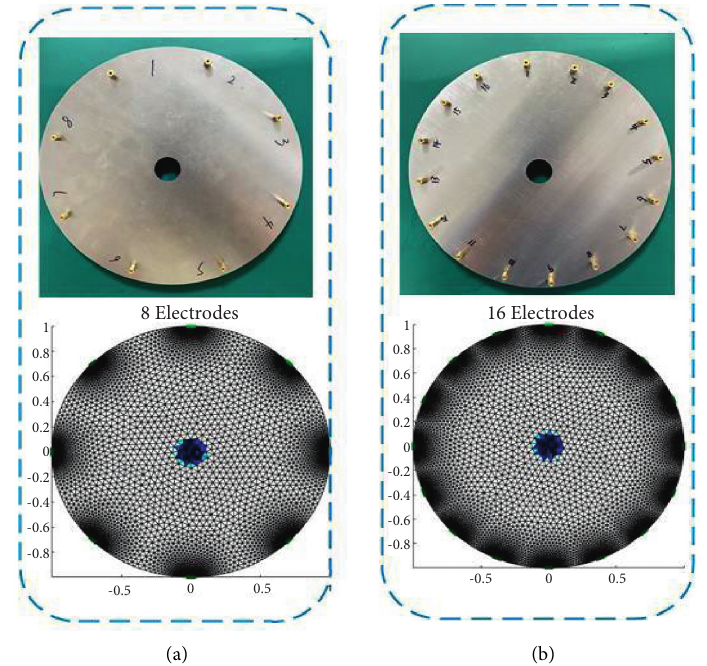
Figure 11: Two-dimensional model diagram: (a) 8-electrode model; (b) 16-electrode model.